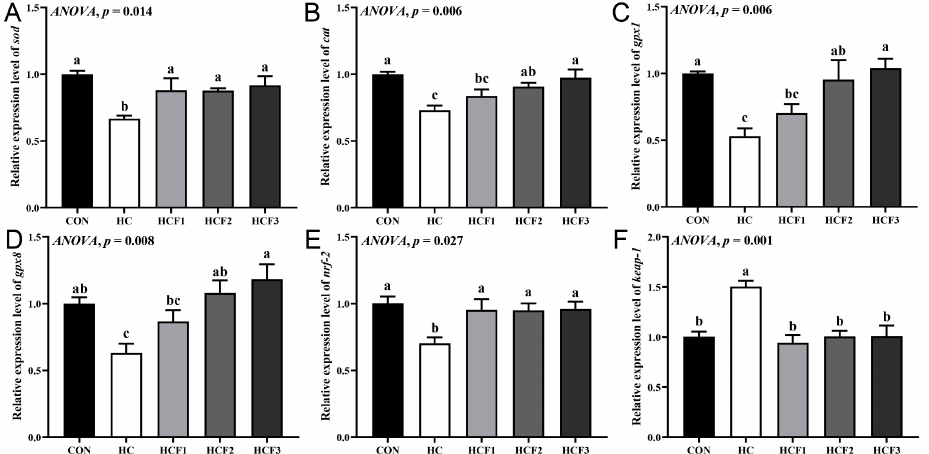
Figure 4. Influences of dietary mulberry leaf flavonoids on antioxidant-related genes' expression in the liver of rice field eels fed on a high-carbohydrate diet. ( A ) sod ; ( B ) cat ; ( C ) gpx1 ; ( D ) gpx8 ; ( E ) nrf-2 ; ( F ) keap1 . Different letters show a significant difference ( p < 0.05).